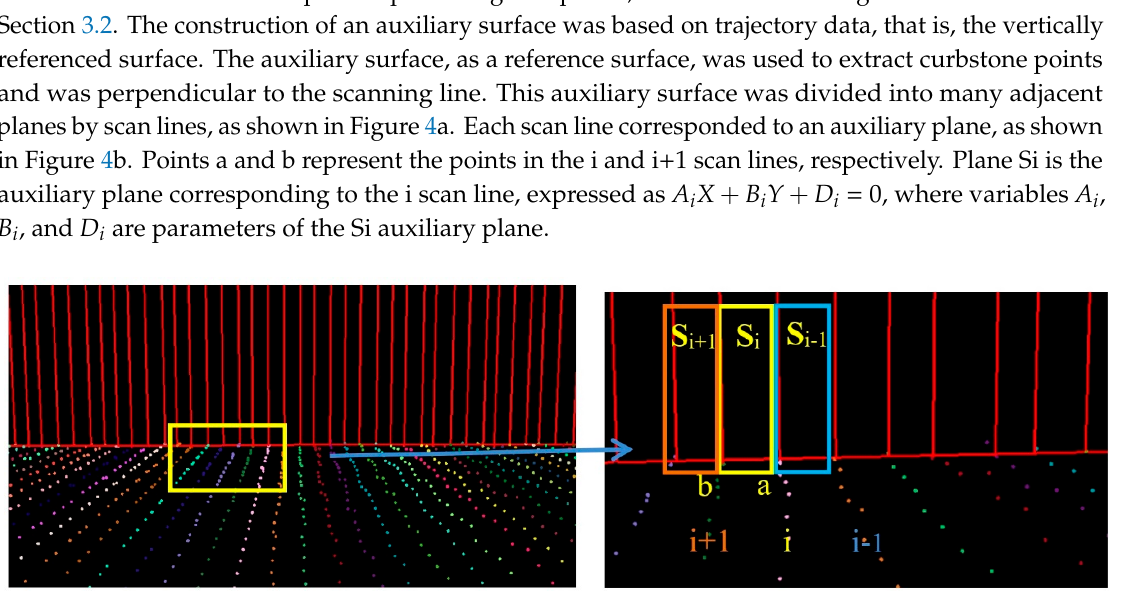
Figure 3. Definition of approximate matrices.